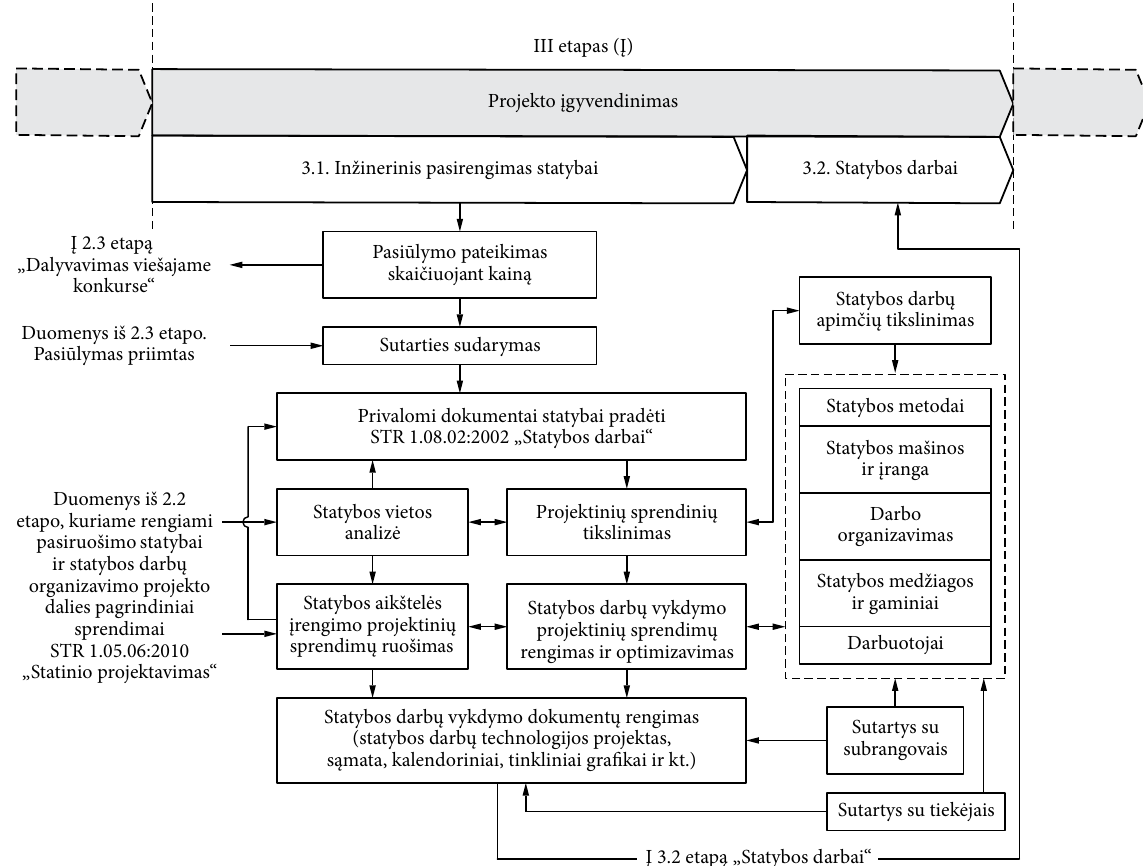
Fig. 2. A structural scheme of engineering